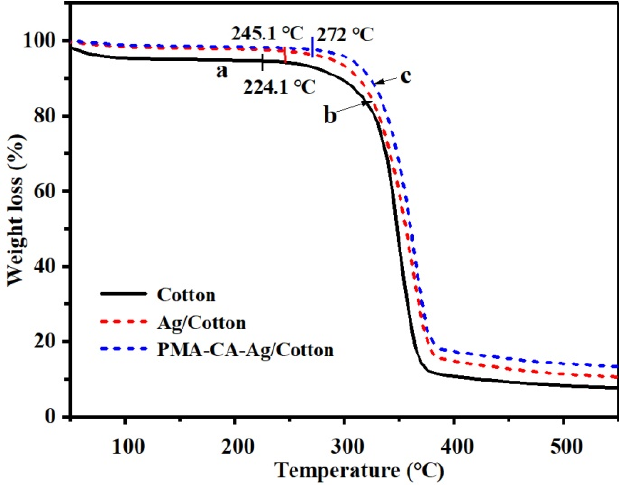
Figure 10. XRD peak-splitting fitting diagram of Unfinished Cotton ( a ), Ag/Cotton ( b ) and PMA-CA-Ag/Cotton ( c ).